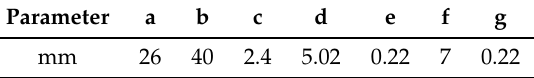
Figure 3. The fabricated sensor and its resonant characteristics. ( a ) signal line of the complementary split-ring resonator (CSRR); ( b ) ground plane of the CSRR and zoom-in of the resonant part; ( c ) measurement result of the transmission characteristic. Table 1. Dimensions of the proposed sensor.